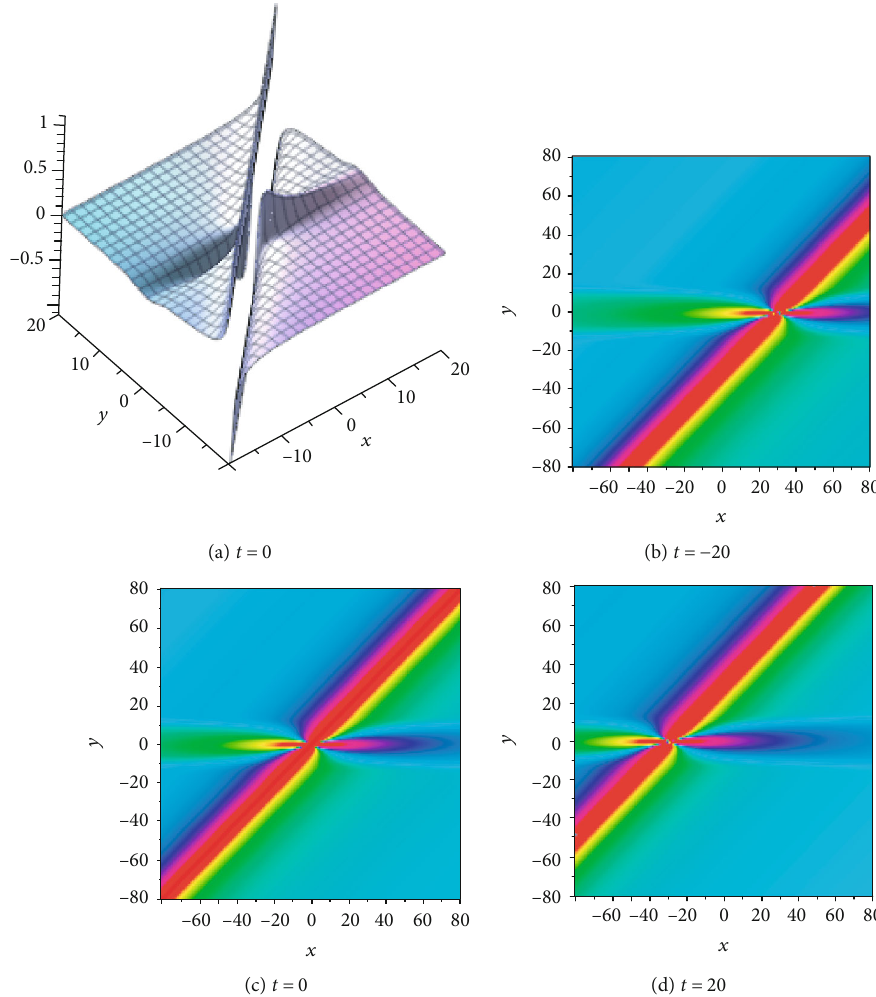
= 1 , and k = 0 . (a) 3- 2 4